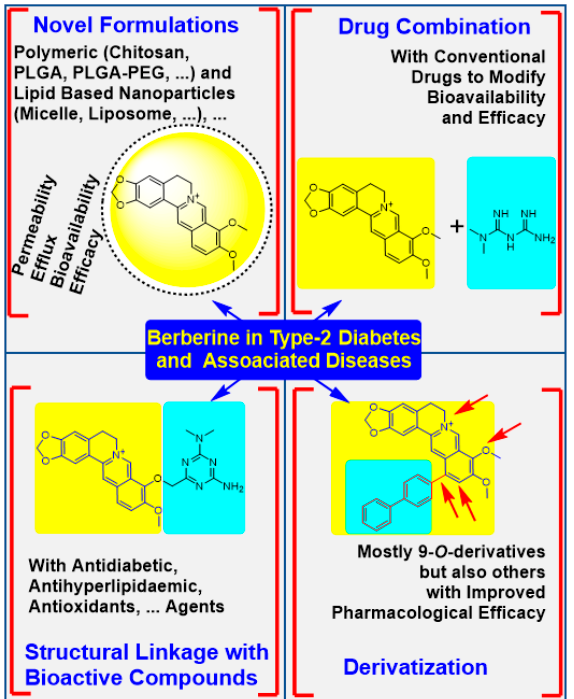
Figure 6. Physicochemical modification approaches for improvement of berberine’s pharmacology in T2D and associated disorders. Advances in formulation technology allowed berberine to be encapsulated alone or together with other agents while chemical modification include derivatization including hybrid formation with other pharmacologically active compounds. These approached have shown improvement in berberine’s absorption while reducing its efflux and degradation in intestinal tissues. The resulting improvement in bioavailability through formulation and efficacy improvement by chemical modification showed a better promise in experimental diabetes and other models of associated diseases.